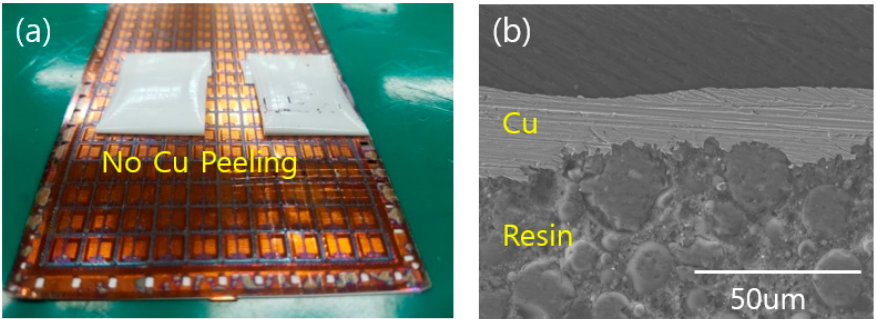
Figure 10. Moisture absorption evaluation of two-layer Rt-QFN: ( a ) Peel off tape test after moisture absorption; ( b ) SEM image of the interface between resin and Cu. absorption; ( b ) SEM image of the interface between resin and